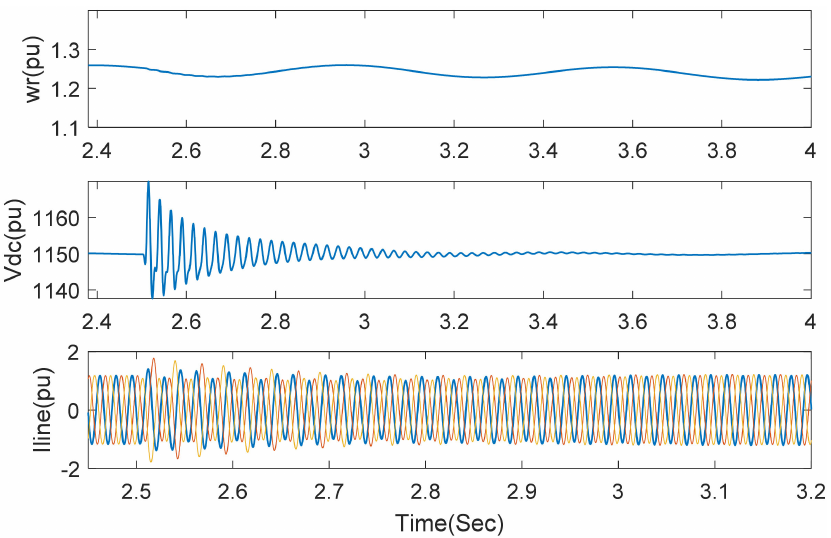
Figure 4. Transient responses of rotor angular speed, DC bus voltage, and transmission line current after 40% series compensation is